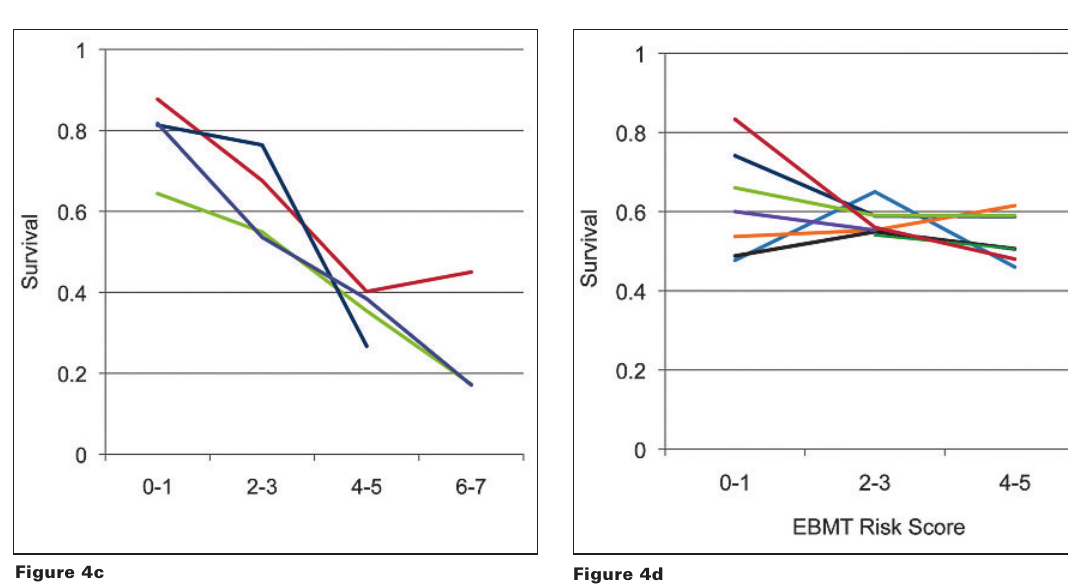
Probability of survival at 5 years, depending on EBMT risk score and centre, allogeneic HSCT.